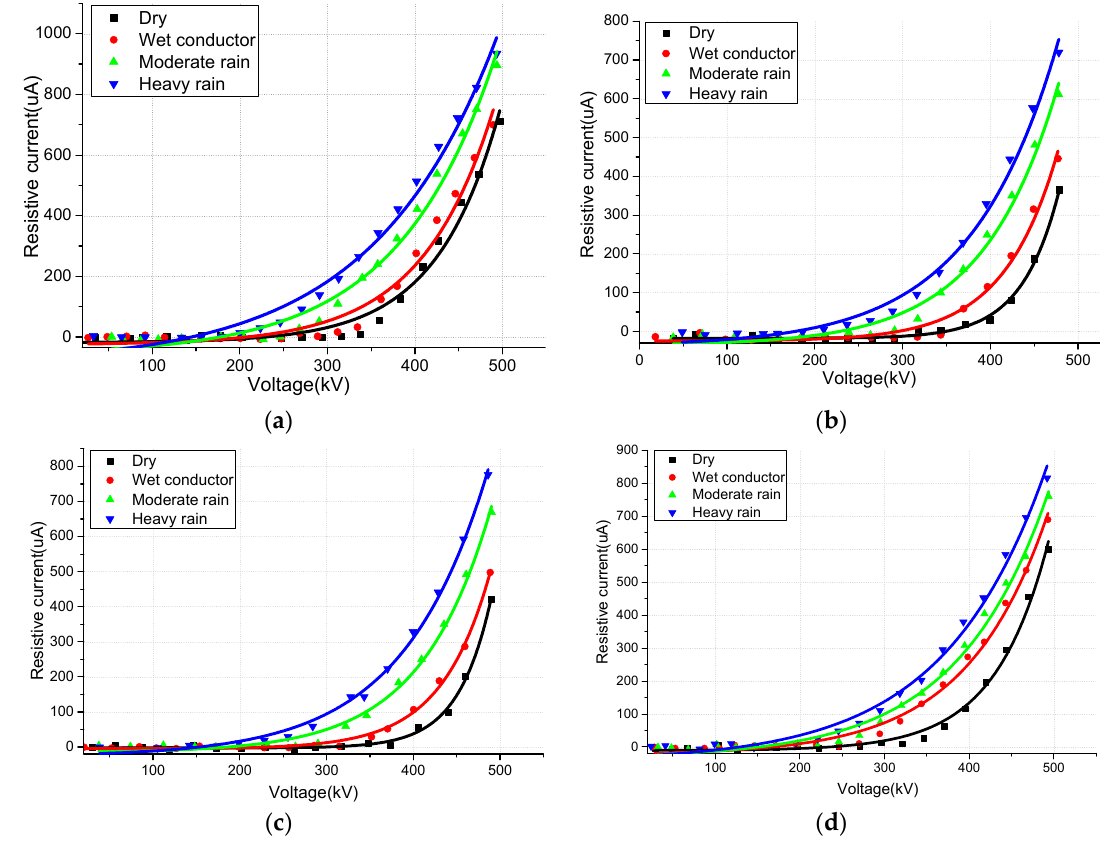
Figure 5. Test results: resistive currents. ( a ) 6 × LGJ720; ( b ) 8 × LGJ720; ( c ) 10 × LGJ720; ( d ) 8 × LGJ630.